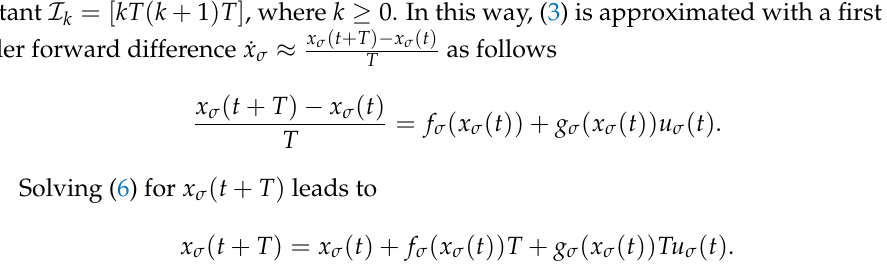
Figure 3. PID Wavenet controller scheme where σ can be left, l or right, r , i.e., σ = is the reference signal, ε σ ( k ) stands for the error signal, the control input is u σ ( k ) , r σ ( k ) models the noise signal, y σ ( k ) is the HRpI (human patient in the haptic loop) output with ˆ y σ ( k ) its estimate, and e σ ( k ) the error estimated, finally, v σ ( k ) stands for the persistence